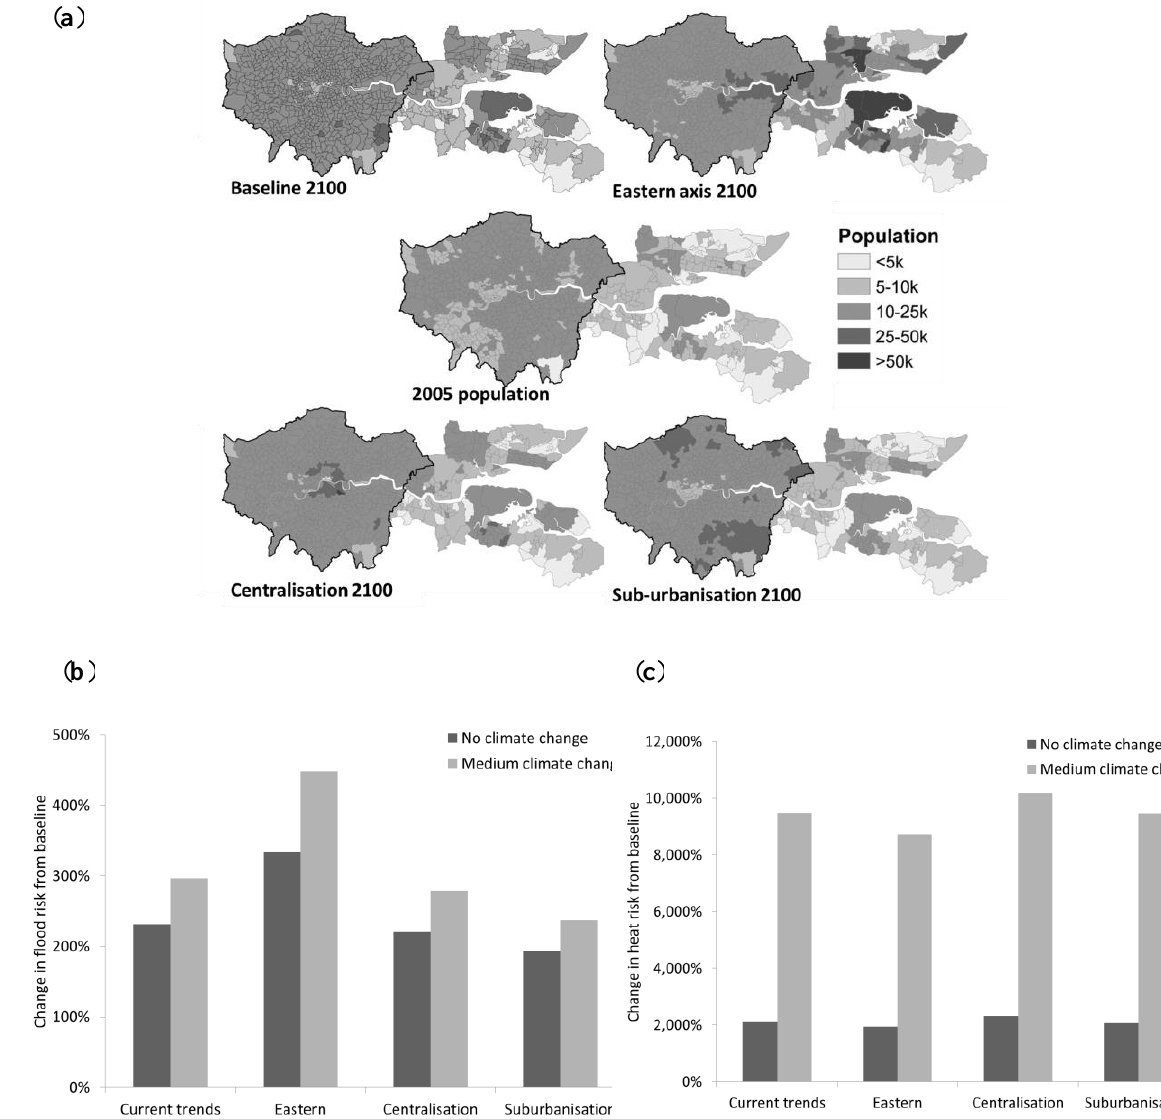
Figure 6. ( a ) Different land use scenarios and their impact on ( b ) flood risk and ( c ) heat risk in 2100 under a UKCP09 medium climate change scenario, and a no climate change